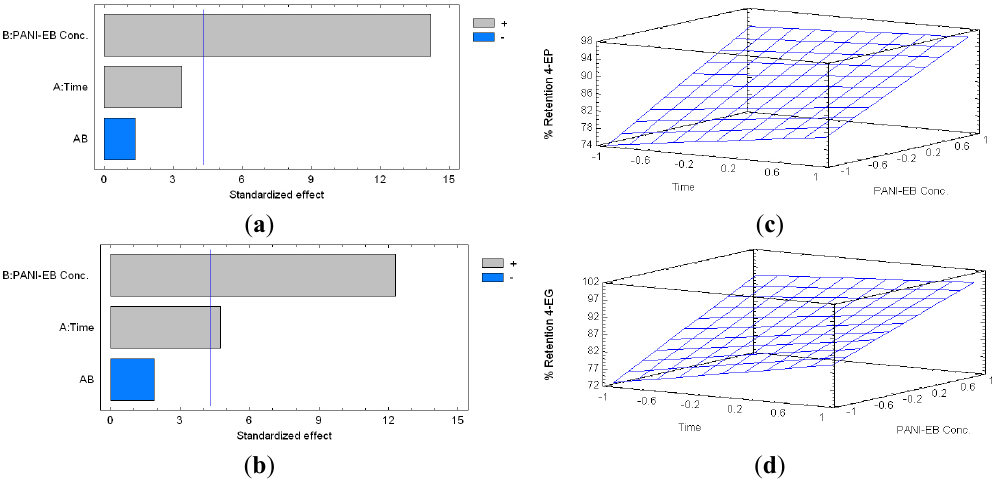
Figure 2. Standardized Pareto charts indicating the percentage of retention of 4-ethyphenol (4-EP) ( a ); and 4-ethylguaiacol (4-EG) ( b ) by PANI-EB treatment (Where: A, time of reaction; B, concentration of PANI-EB; and AB, interaction. The blue line represents the critical t- value, 95% confidence, with 10 total degrees of freedom); and estimated response surfaces of 4-EP ( c ) and 4-EG ( d ) retention.